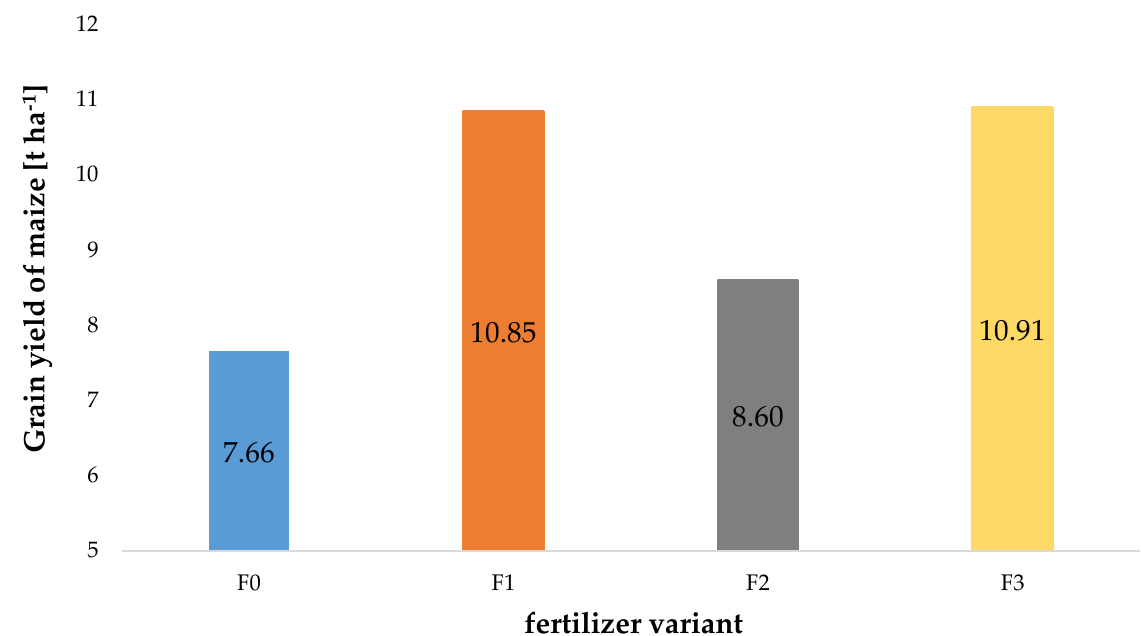
Figure 8. Yield of maize grain depending on the fertilization applied (F0—control; F1—foliar fertilization; F2—localized fertilization: microgranules for precision application into the soil; F3—localized fertilization: microgranules for precision application into the soil with foliar fertilization).